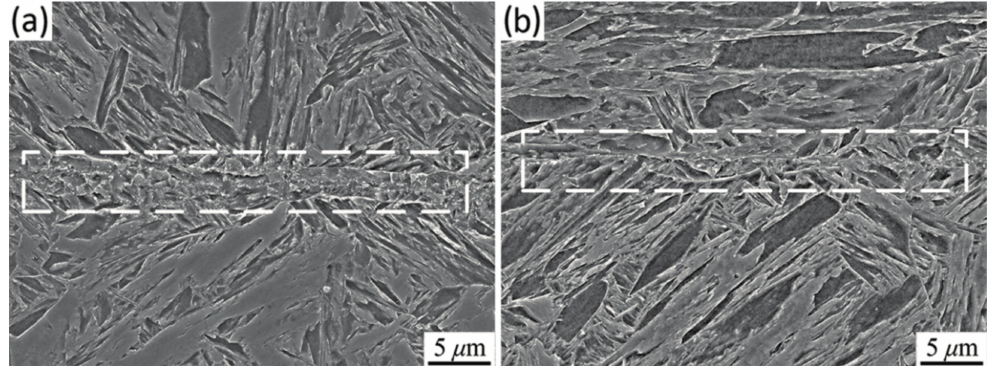
Figure 12. SEM micrographs of crack healing zone at 1000 ◦ C under various hot pressures for 30 min: ( a ) 2 MPa; and ( b ) 6